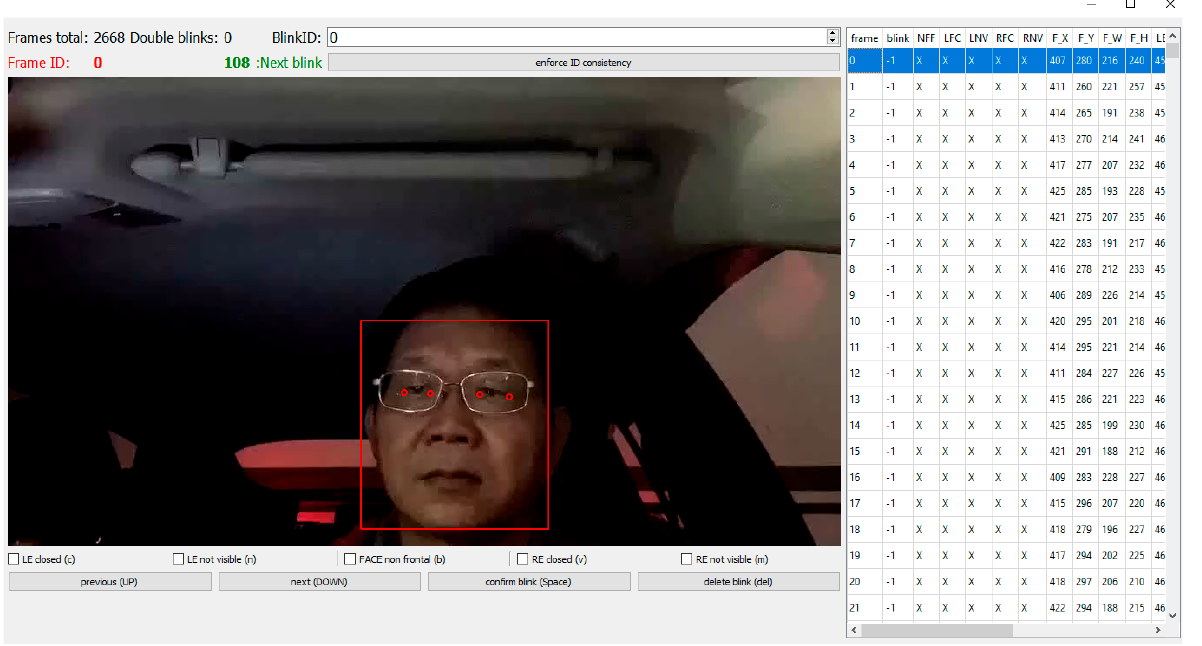
Figure 4. Video labeling process with Eyeblink Annotator 3.0. Figure 3. Video labeling process with Eyeblink Annotator 3.0.